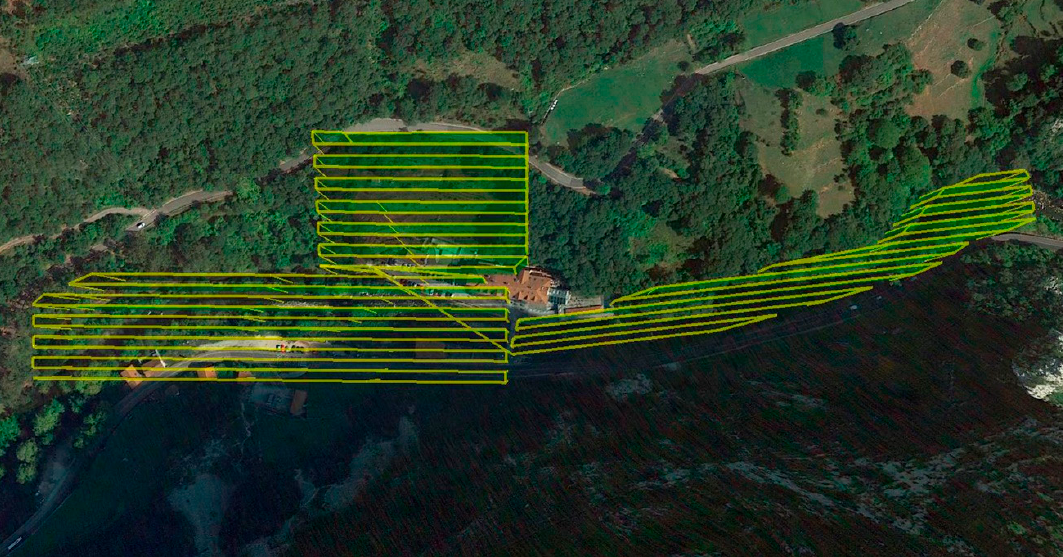
Table 2. Thermal dual sensor specifications.